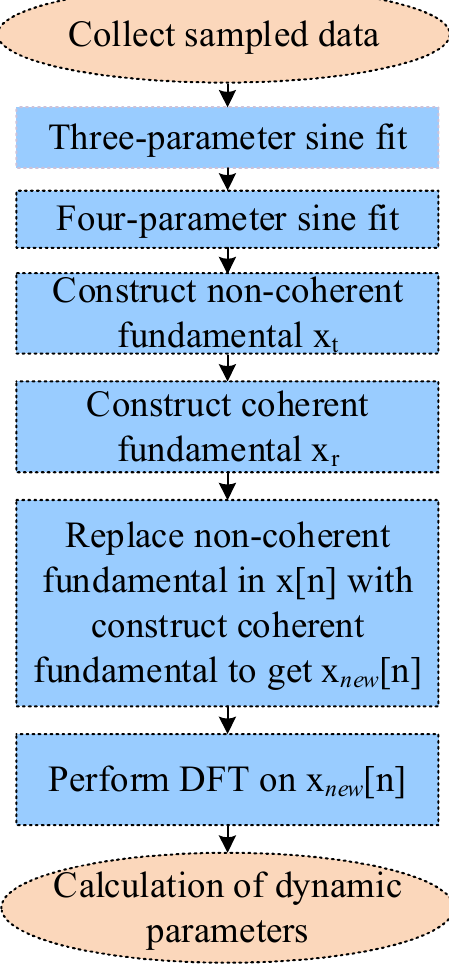
Figure 4. Algorithm process